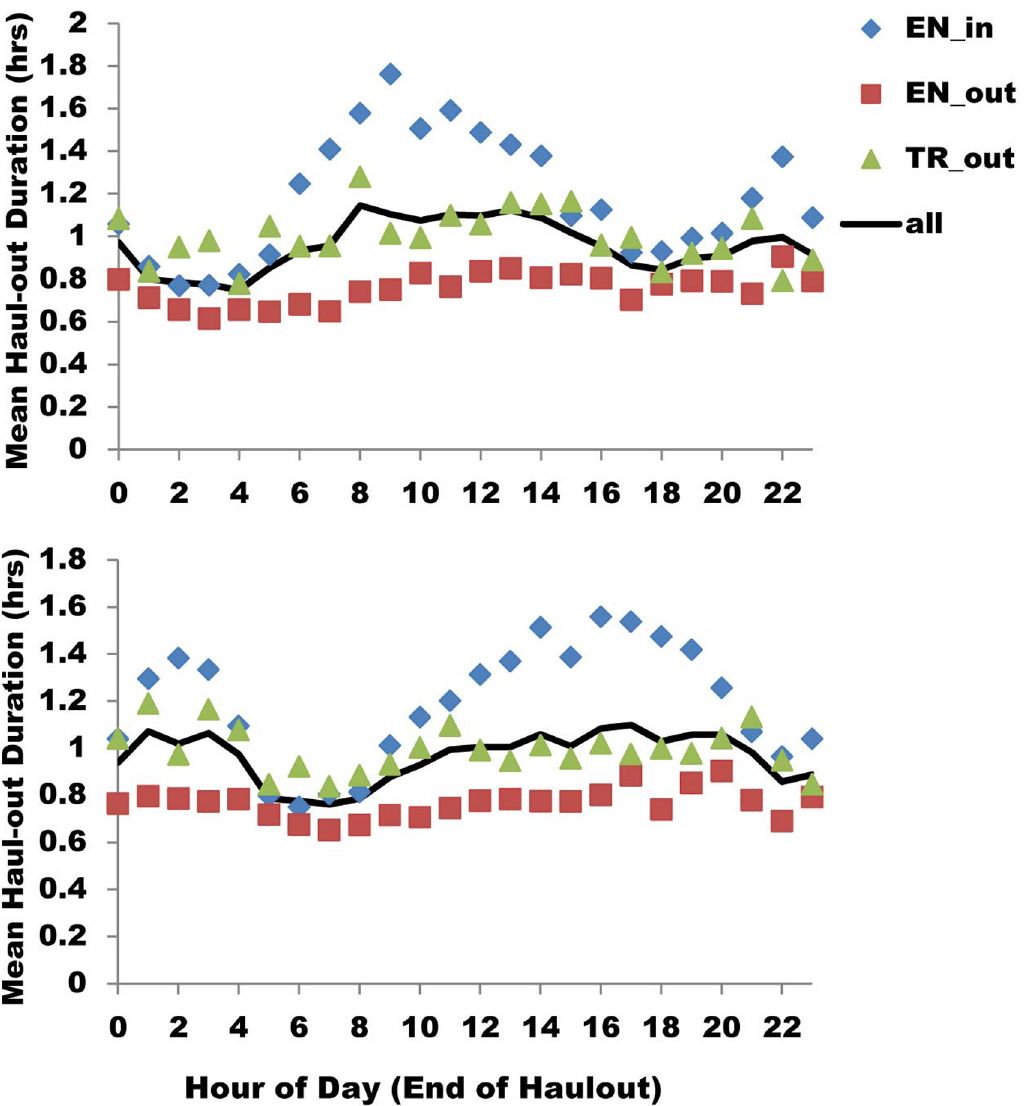
Fig 11. Haul-out duration for radio-tagged harbor seals in each inlet by start and end time. Top Panel: Geometric mean duration (in hours) of haulouts for radio-tagged harbor seals in inner Endicott (EN_in), outer Endicott (EN_out) and outer Tracy (TR_out) Arms relative to hour of the day at the start of the haulout. Bottom Panel: Average duration (in hours) of haulouts for radio-tagged harbor seals detected at each monitoring site relative to hour of the day when the haulout